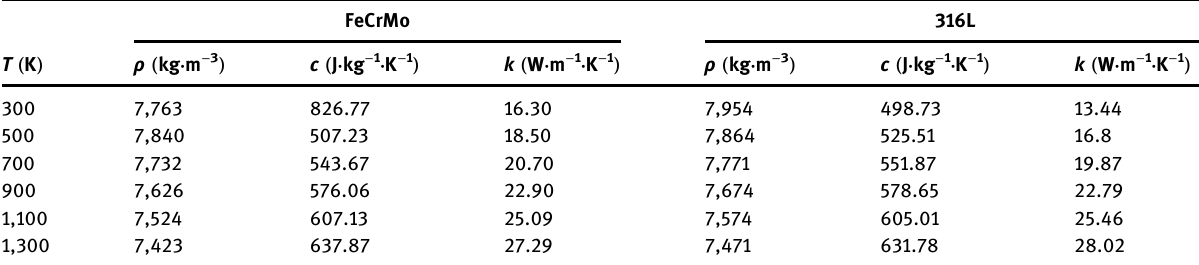
Table 3: Physical parameters FeCrMo 316L